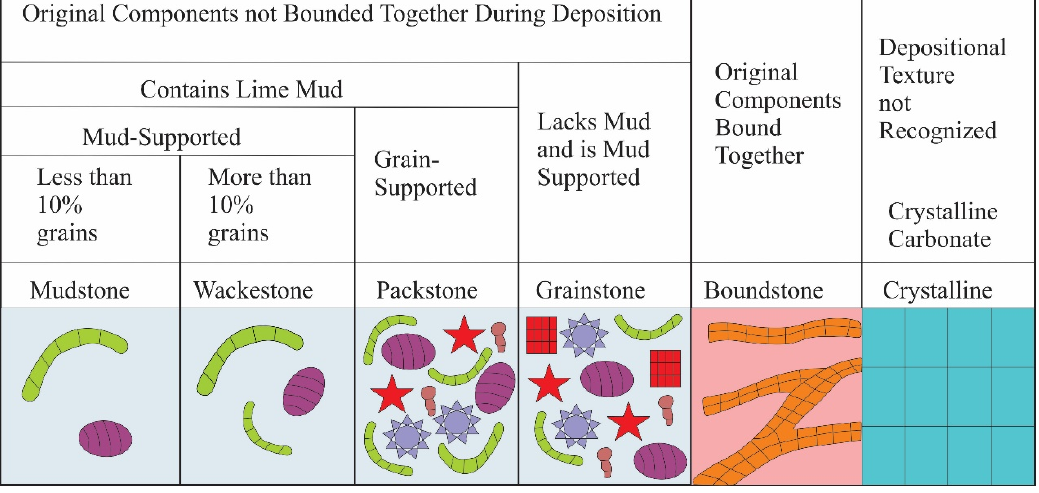
Figure 4. Representing the extended classification of limestone based on depositional texture. Porosity Classifications Carbonate rock has a broad range of pore sizes, and the network of connections within the rock is often complicated. There is usually a lack of correlation between poros- ity and other physical parameters such as permeability and velocity. Understanding how carbonate reservoirs form porosity is critical [25–28]. The structure of the pores has a sig- nificant influence on permeability and elastic properties [10,29,30]. Various rocks with the same porosity but varying permeability and acoustic velocity may be encountered [31]. The pore structure of carbonate rocks has been shown to affect the petrophysical proper- ties in many studies [32–39]. Most studies support a dual-porosity model, since geologists and petrophysicists are unable to agree on how to define pore types. [31,40–44]. Archie [45] was the first to investigate the link between rock fabric and petrophysical parameters, highlighting the relevance of pore structure in defining pore types. Table 1 shows the matrix texture and pore type visibility used in the Archie [45] classification (Table 2).